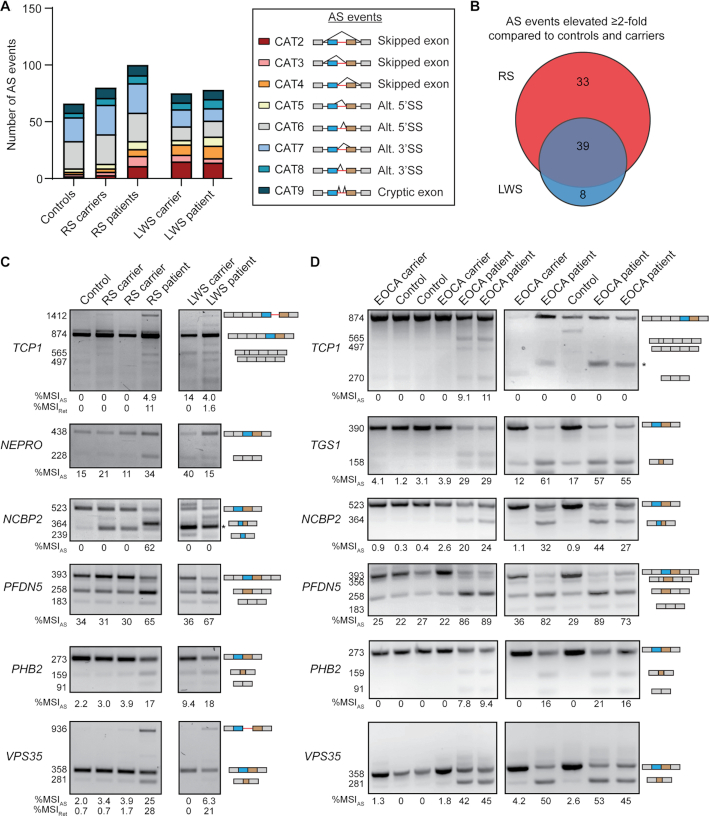
Roifman syndrome and early-onset cerebellar ataxia are characterized by higher levels of AS around minor introns than Lowry–Wood syndrome. (A) Bar graph with number of AS events around the minor intron in each individual. Schematics of different types of AS events are shown on the right. (B) Venn diagram of the number of minor introns with elevated AS in the RS and LWS patients compared to healthy controls and the respective carriers. Agarose gel images of RT-PCR products resulting from AS around minor introns in PBMCs of individuals with mutation in RNU4ATAC(C) and RNU12(D). Product size (in base pairs) of products is shown on the left; product schematics are shown on the right. The %MSIAS was calculated using ImageJ. Asterisks mark non-specific products. RS = Roifman syndrome; LWS = Lowry–Wood syndrome; EOCA = early-onset cerebellar ataxia. See also Supplementary Figures S9–S11.